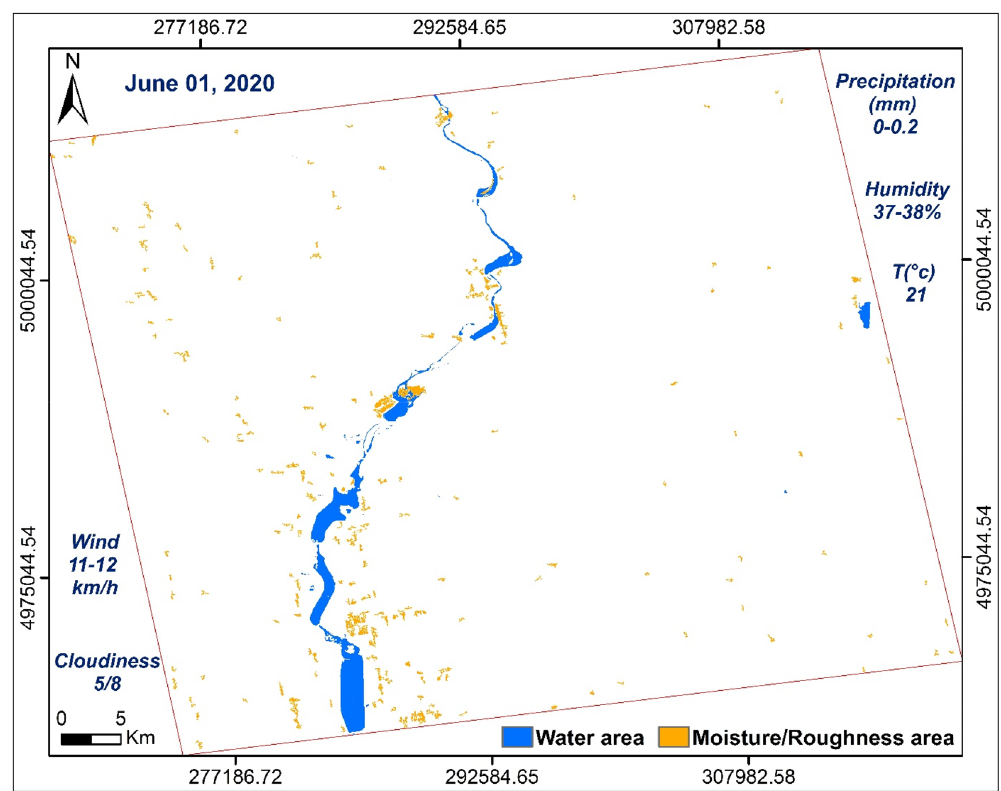
Figure 8. Map produced using ArcGisPro 2.8.1, showing areas of water and moisture/roughness, 01/06/2020.